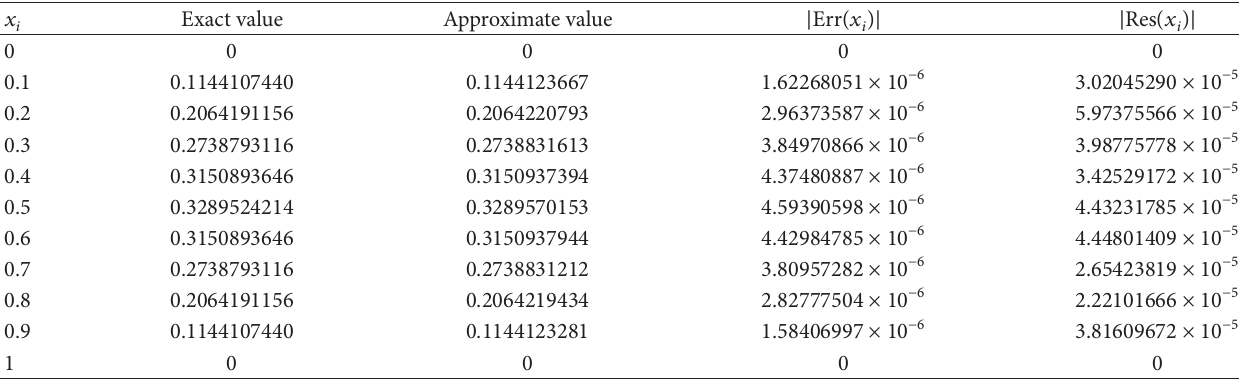
Table 4: Numerical results for Bratu’s problem when 𝜇 = 2 .